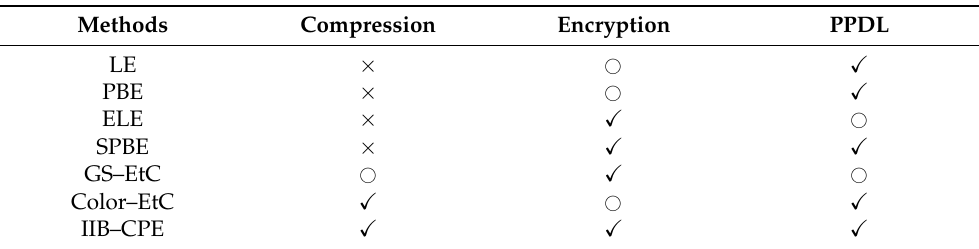
Table 3. Performance comparison of different perceptual encryption methods to enable privacy- preserving deep